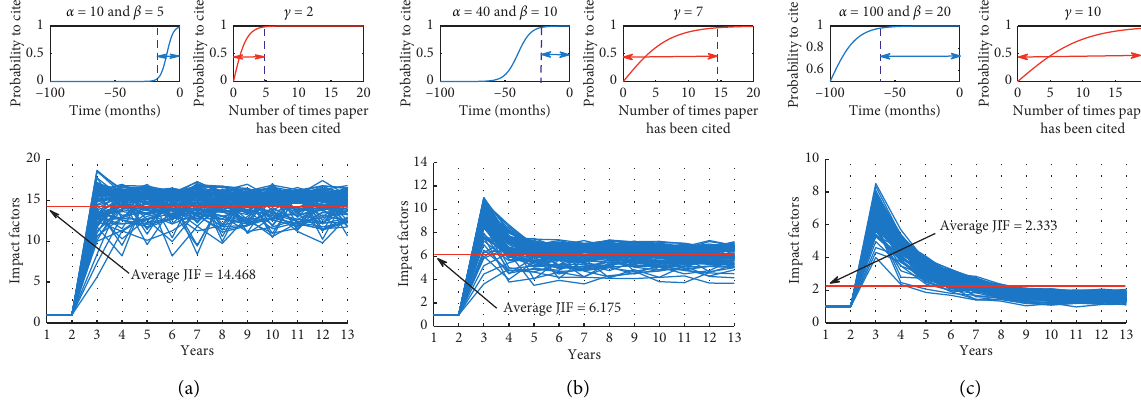
Figure 11: Variation of the JIF within 13 years in 100 Monte Carlo simulations with T